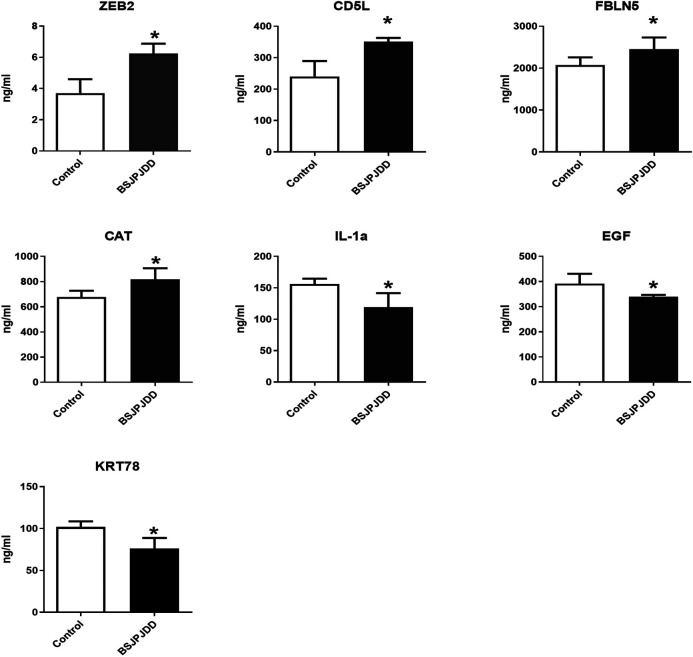
Plasma protein expressions in PCRC patients with LYKD-SDS treated with BSJPJDD (n = 58) and without BSJPJDD (n = 58). The validation tests were carried out by ELISA plasma ZEB2,CD5L,FBLN5, and CAT were up regulated,IL-1A, EGF and KRT78 were down-regulated by BSJPJDD *p < 0.05, BSJPJDD group vs control group.